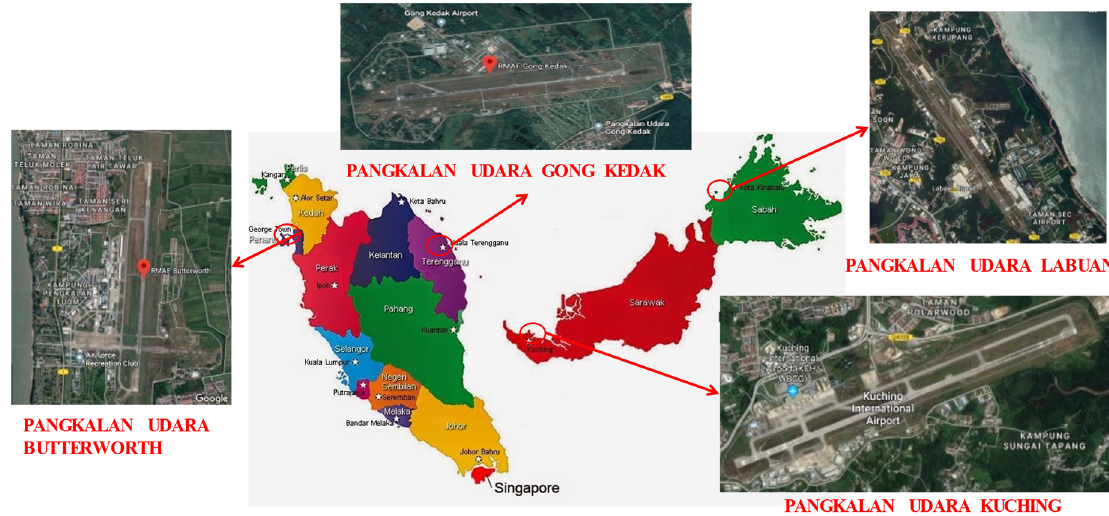
Figure 1. Location of RMAF Bases .